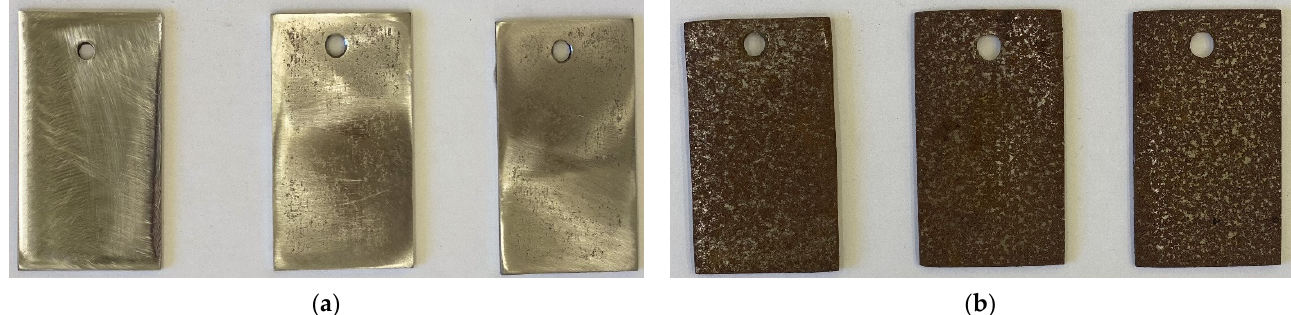
Figure 4. Steel samples after weathering tests for 9 months: chamber treatment with CIN vapors ( a ); without chamber treatment ( b ).